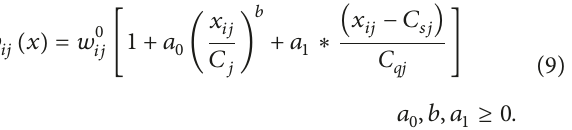
If the directed edge is the right edge 𝑘 between links , 𝐿 ) , 𝛿 𝑢 V = 1 in (8). Otherwise, 𝛿 𝑢 V (𝐿 𝑢 V 𝑖𝑗,𝑘